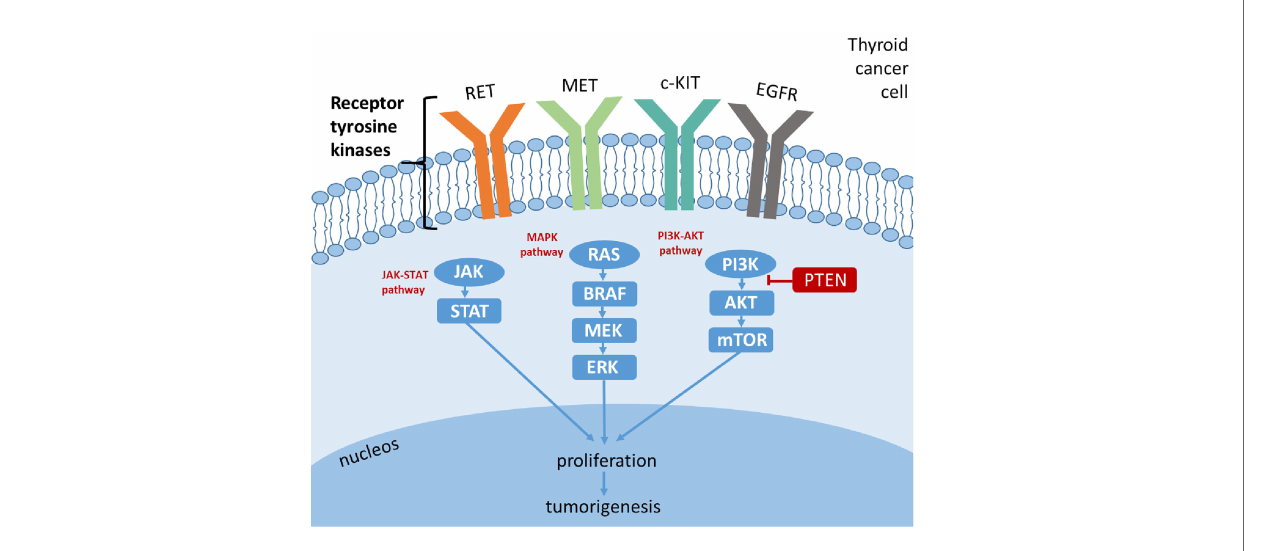
FIGURE 1 | Signaling pathways in thyroid